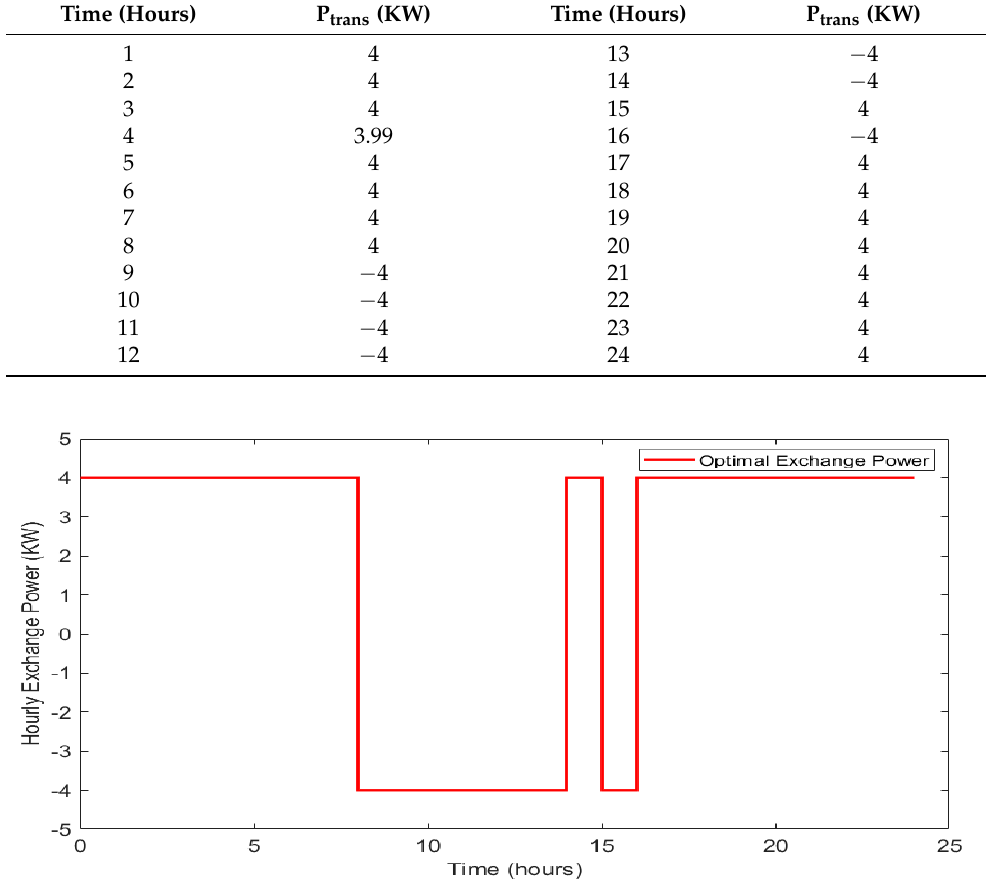
Figure 9. Optimal hourly exchange power.